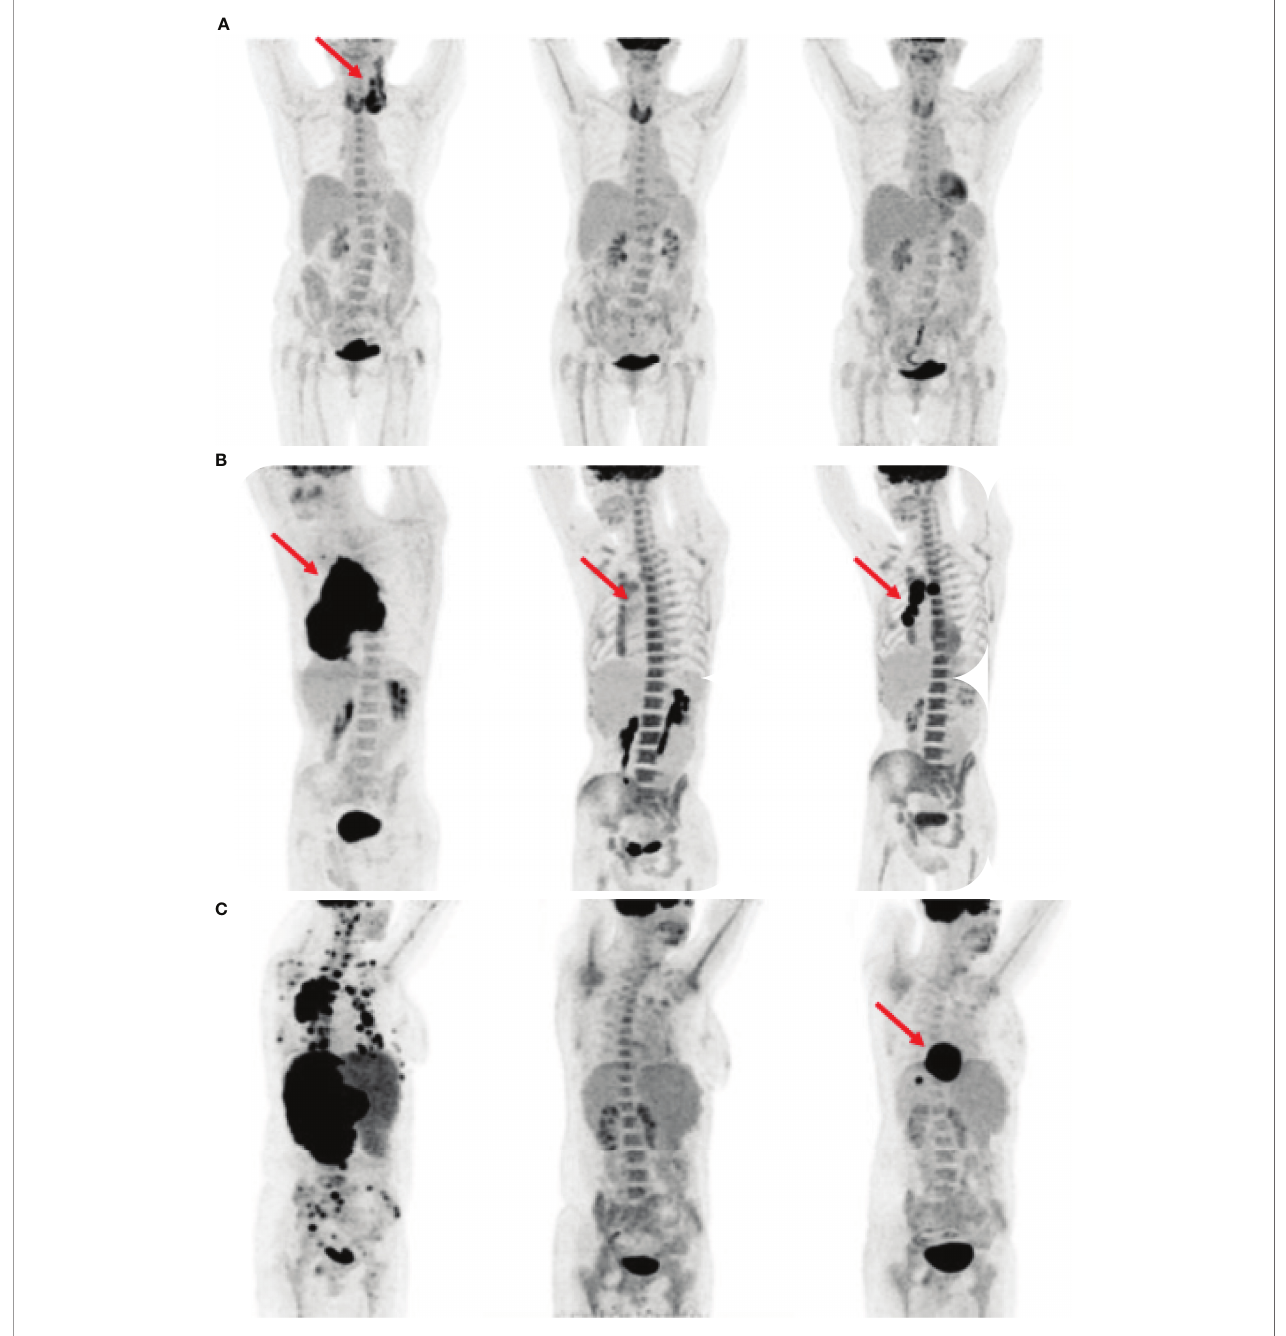
FIGURE 1 | Comparisonofclinicaloutcomes basedonmaximum intensityprojection(MIP) imagesinthree patients (A – C) . Byeach patient, the fi rst imageshows primary staging,thesecondshows interim PETscan, andthethirdshowspost-treatmentrestaging scan. The redarrowsindicateFDGavidlymphomafoci. (A) Patientincomplete remissiontotreatment. TheincreasedFDGuptakeinallthreeimageswas asignofthyroiditis. (B) Patient withoutcompleteremissionduringandafter thetherapy. The interim scanshowedDeauvillescore 4. (C) Patienthadaninterim